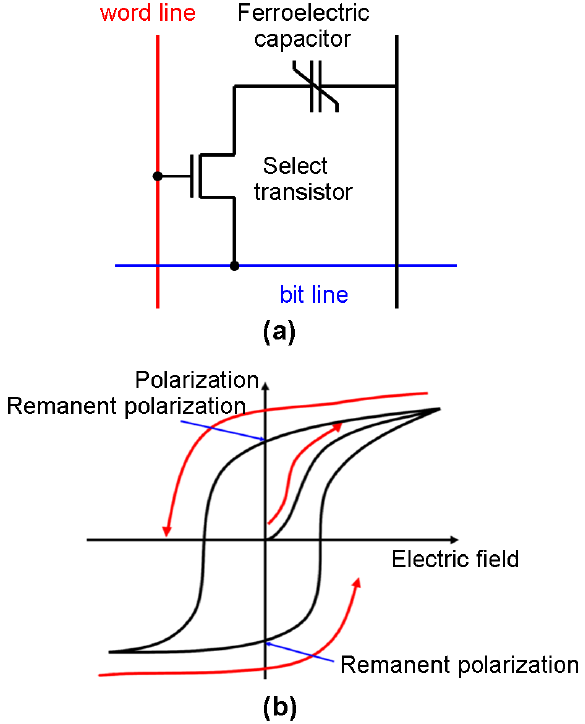
Figure 3. FeRAM structure and polarization: ( a ) a 1T1C-based structure (FeRAM storage unit); ( b ) a ferroelectric loop.